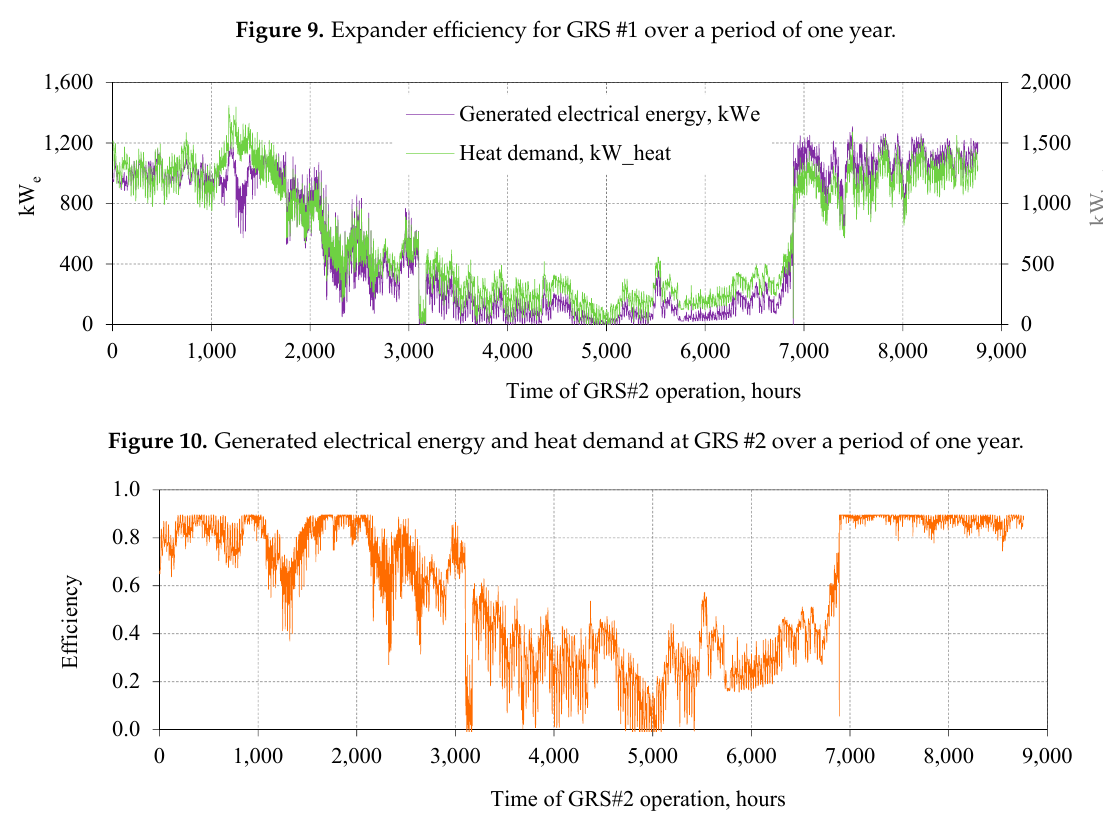
Figure 11. Expander efficiency for GRS #2 over a period of one year.